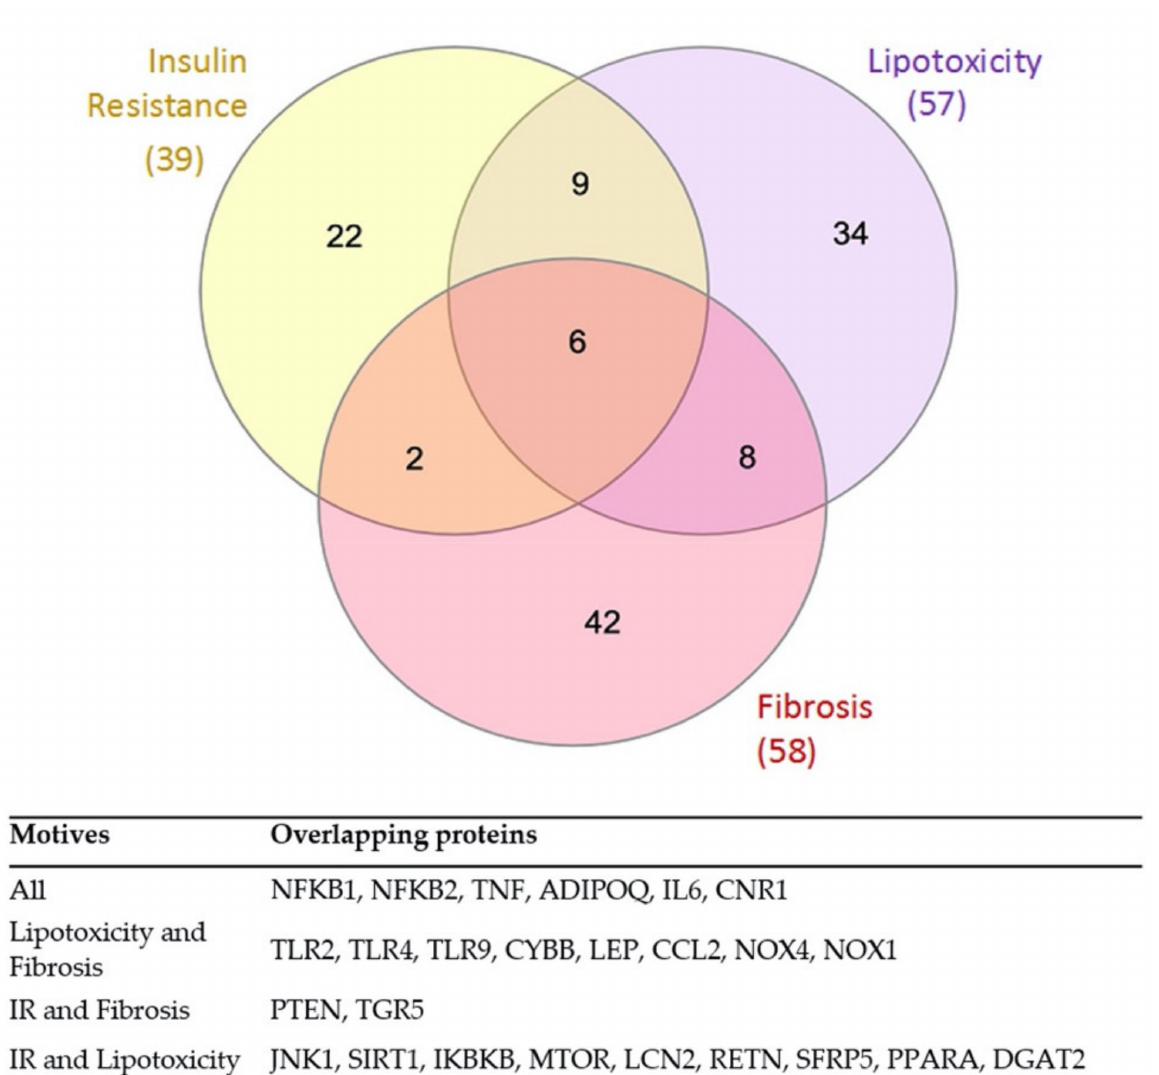
Figure 4. Overlap of effector proteins between the three NAFLD motives evaluated in the project: VENN diagram showing the number of effector proteins overlapping between the three indicated NAFLD motives. There are 39 proteins involved in IR mechanism, 57 in lipotoxicity, and 58 in fibrosis. Concretely, there are 9 proteins involved in IR and lipotoxicity, 6 in lipotoxicity and fibrosis, and only 2 in IR and fibrosis. In this regard, there are six proteins involved in the three motives of NAFLD pathogenesis: NF κ B1, NF κ B2, TNF, ADIPOQ, IL-6, CNR1. IR, insulin resistance; NFKB, nuclear factor kappa B; TNF, tumour necrosis factor; ADIPOQ, adiponectin; IL6, interleukin 6; CNR1, cannabinoid receptor 1; TLR, toll-like receptor; CYBB, cytochrome b-245 heavy chain; LEP, leptin; CCL2, C-C motif chemokine 2; NOX, NADPH oxidase; PTEN, phosphatase and tensin homolog; TGR5, G protein-coupled bile acid receptor-1; JNK1, c-Jun N-terminal kinase; SIRT1, sirtuin 1; IKBKB, inhibitor of nuclear factor kappa B kinase subunit beta; MTOR, mammalian target of rapamycin serine/threonine-protein kinase; LCN2, neutrophil gelatinase-associated lipocalin 2; RETN, resistin; SFRP5, secreted frizzled-related protein 5; PPARA, peroxisome proliferator-activated receptor alpha; DGAT2, diacylglycerol O-Acyltransferase